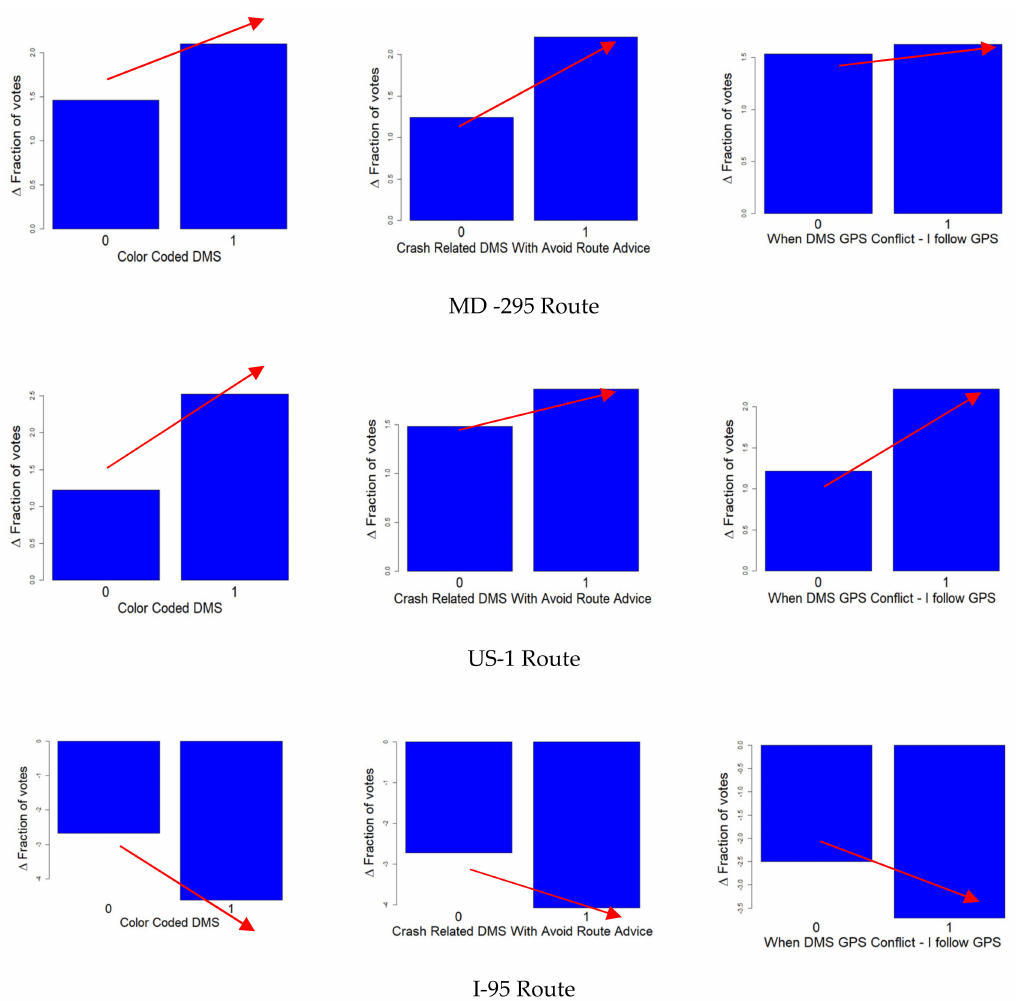
Figure 10. PDPs of important variables impacting diversion behavior (the direction of the trend is shown by the red